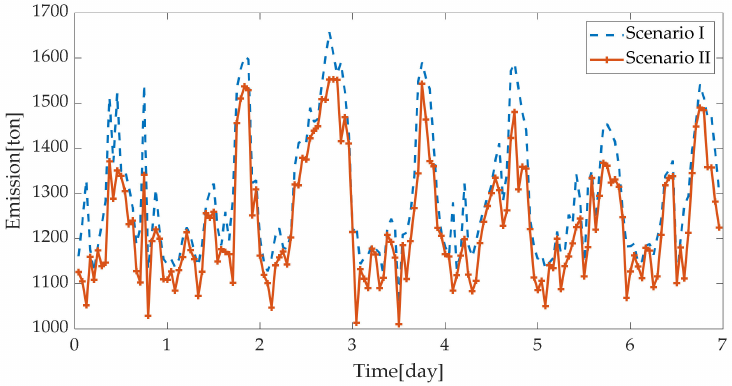
Figure 6. Comparison of CO 2 emission.